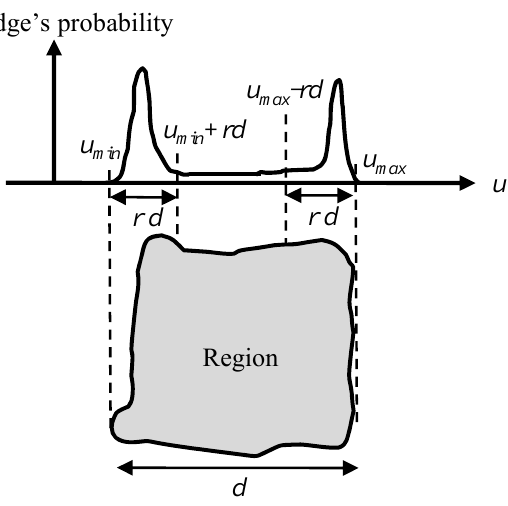
Figure 6. Delineation of the rectangular boundary of the model. Edges are projected onto the principal direction of the region (called the “u-axis”), and a probability distribution is generated. Maximum probability is searched within an interval of width rd , and the boundary is determined at the u value whose probability is